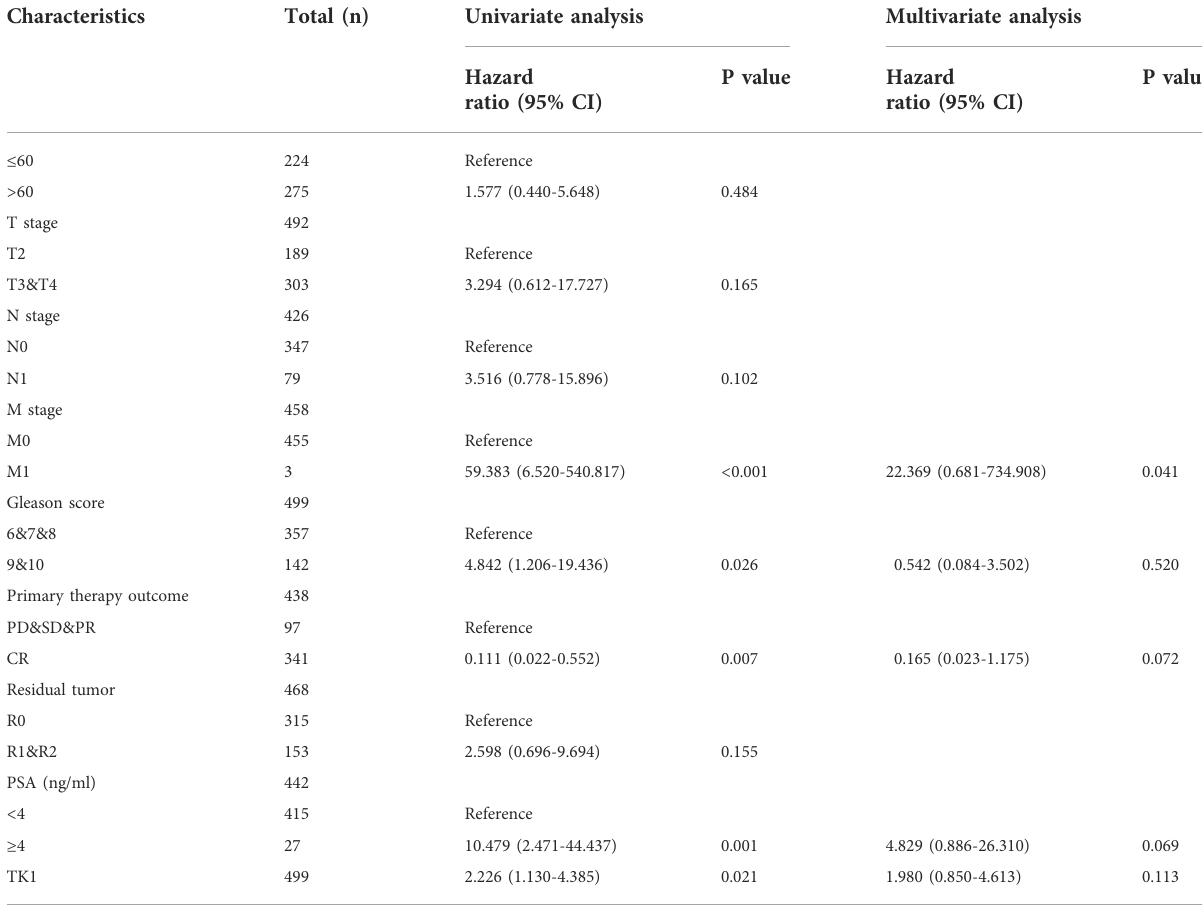
TABLE 2 Univariate and multivariable Cox regression of TK1 expression for overall survival in PCa patients.